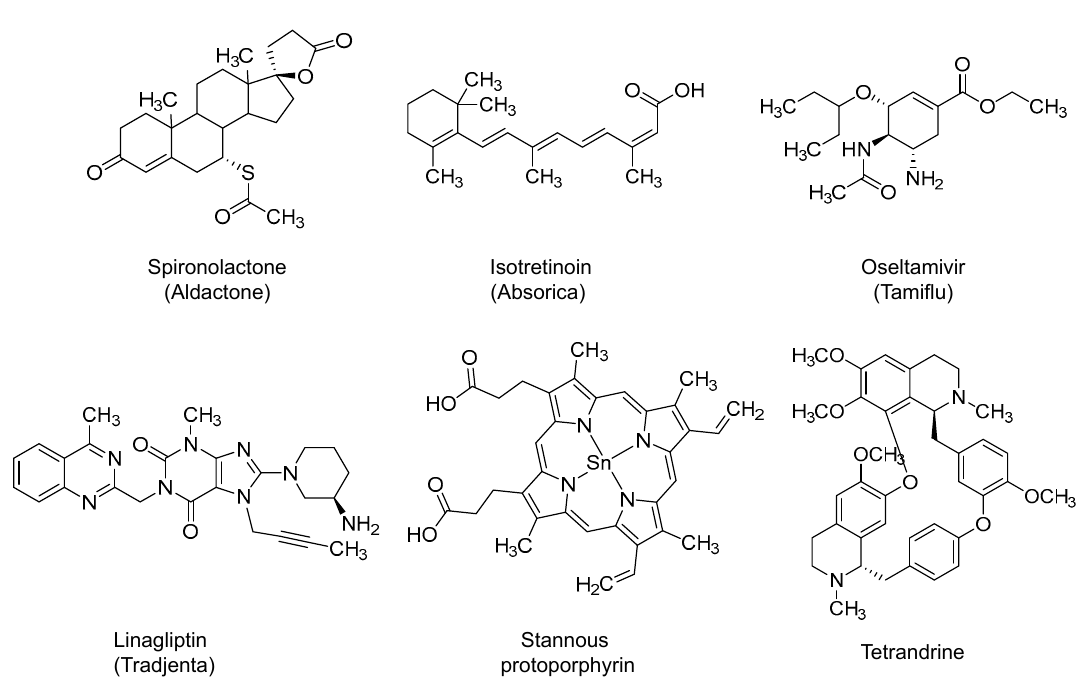
Figure 10. The chemical structures of miscellaneous agents that are also being tested in clinical trials for COVID-19 patients and exhibit inhibitory e ff ects on the early events of the viral life cycle. Important among them are the steroid-based potassium sparing diuretic spironolactone, which has been shown to block the host androgen receptors, and thus, to decrease the transcription of TMPRSS2 gene. Linagliptin is dihydro-purinedione-based inhibitor of DPP-4, a functional receptor for the spike protein of MERS-CoV, and a potential receptor for SARS-CoV-2. It also exhibits therapeutically beneficial anti-inflammatory effects.